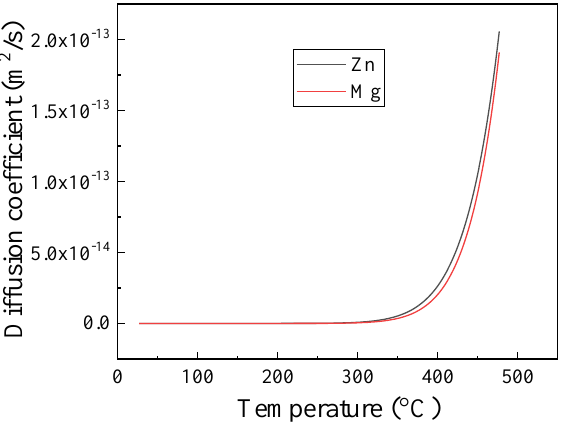
Figure 13. The di ff usion coe ffi cients of Zn and Mg change with temperature in the heating Figure 13. The diffusion coefficients of Zn and Mg change with temperature in the heating stage. It is clear that the diffusion coefficients of both Zn and Mg are small under 300 °C. It only took 20 s for the rapid heating to heat to 300 °C, so few η particles dissolved below 300 °C in the fast heating stage, resulting in the slight reduction in EC shown in Figure 6. However, the longer time (~5.5 h) of slow heating to 300 °C is sufficient, even at this lower temperature, to enable extensive precipitate dissolution, leading to a rapid decrease in EC, as shown in Figure 6. Although the heating time for the FH sample is still short, Figure 13 shows a rapid increase in the diffusion coefficients of both the Zn and Mg elements in the temperature range of 300–450 °C. The diffusion coefficients, or